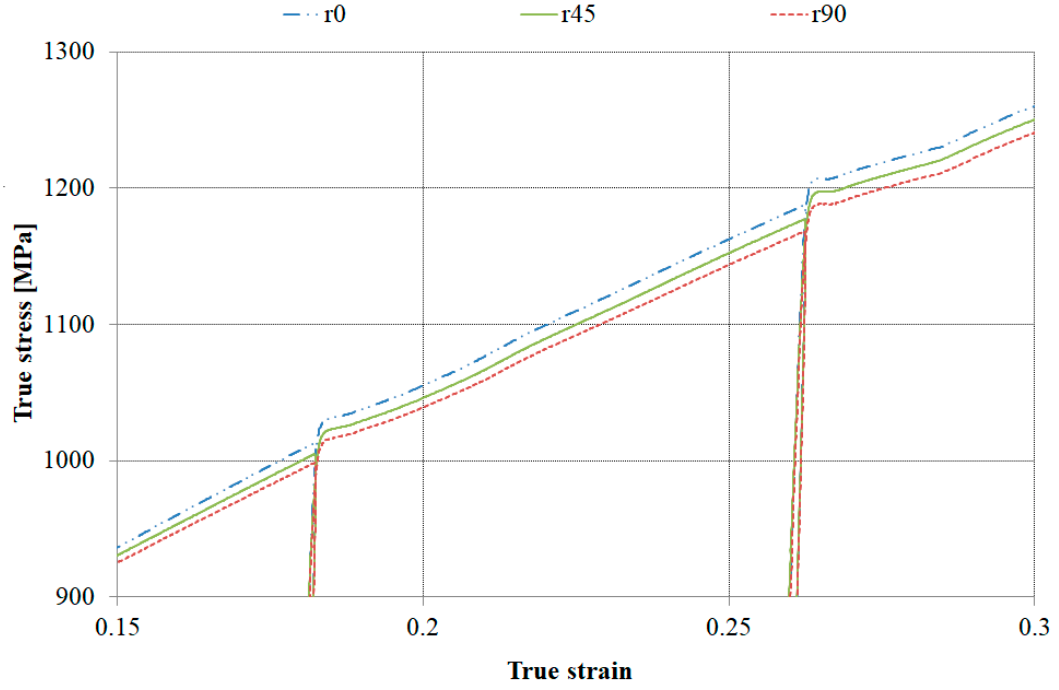
Figure 9. Highlight of the yield plateaus presented in Figure 8.